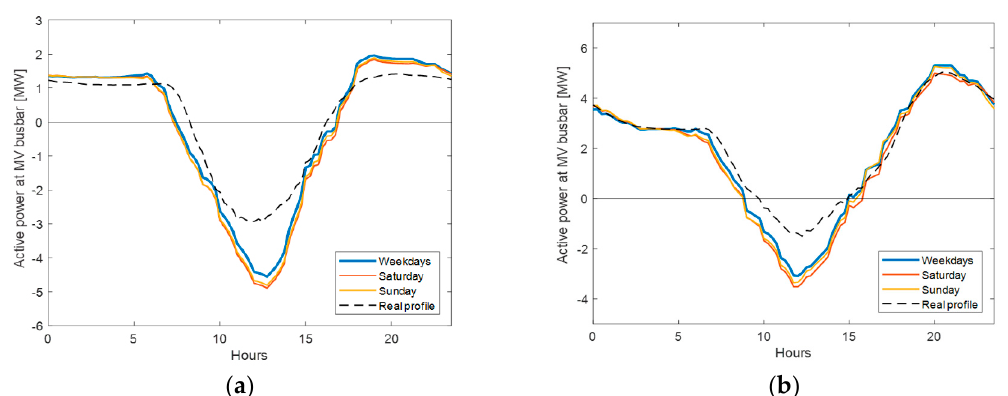
Figure 3. Active power at MV side of the primary ESS for fast growth scenario during spring ( a ) and summer ( b ) considering the impact of Home stations and pole stations.